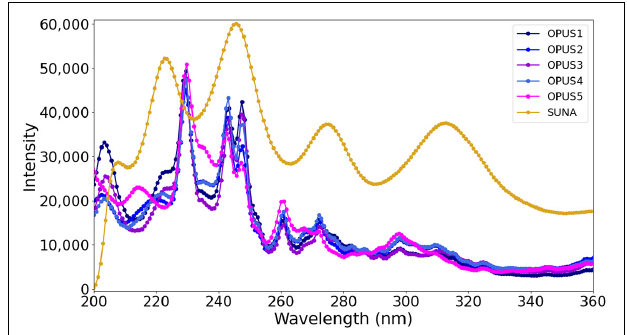
FIGURE 11 | The detector intensity of the optical nitrate sensors in deionized water at all